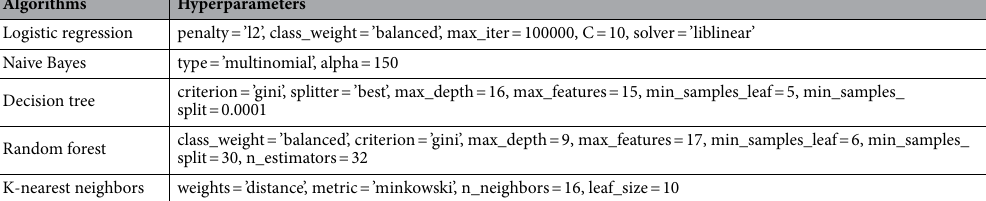
Table 2. Hyperparameters of the algorithms.